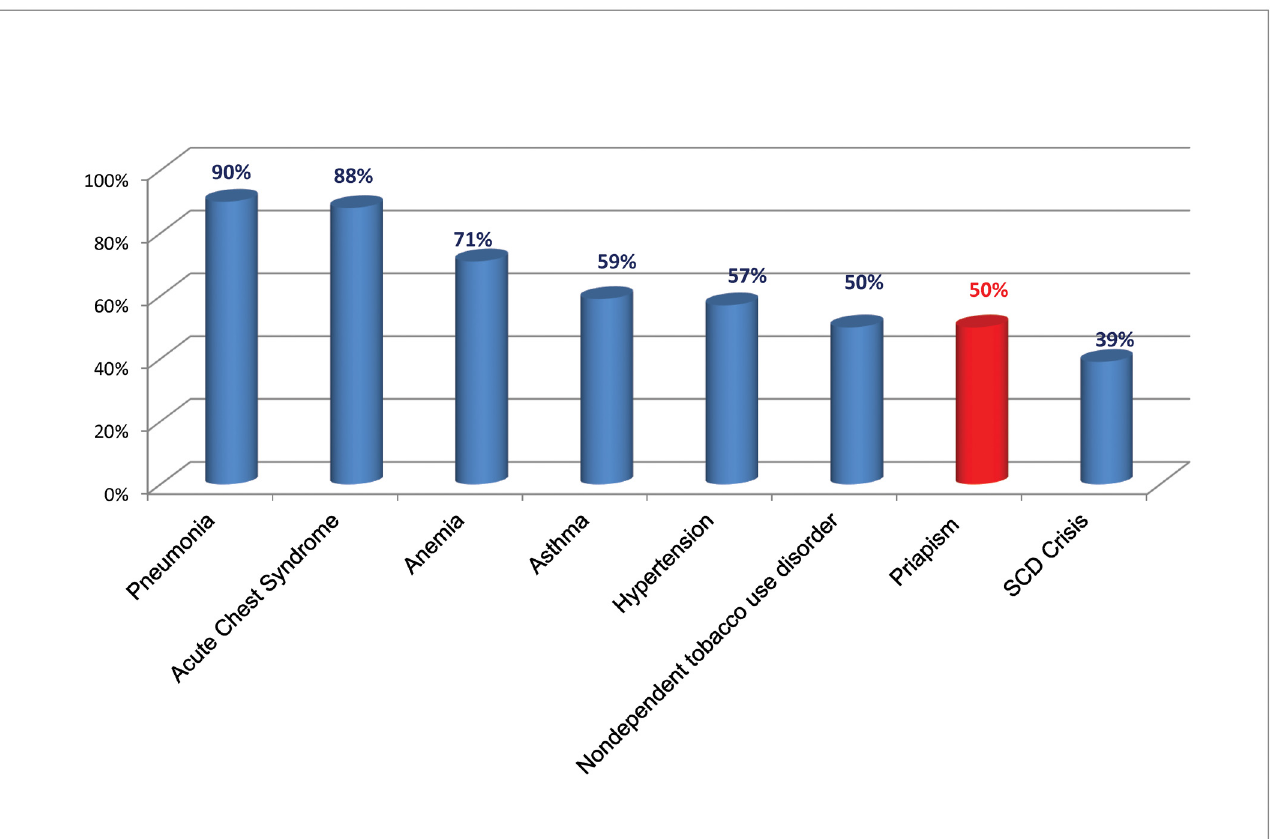
Fig 1. Percentage ED visits resulting in hospitalizations by top co-occuring conditions.